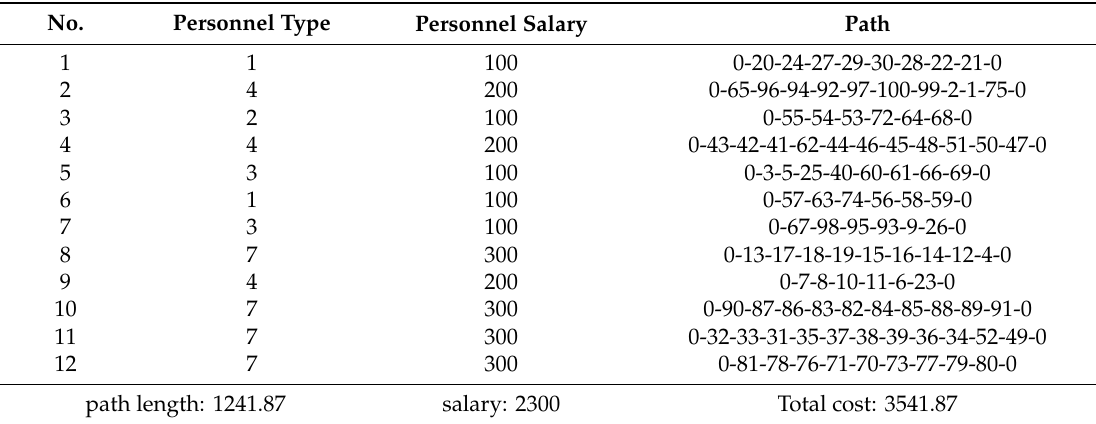
Table 9. Results of the multi-skilled human resource path studied in this